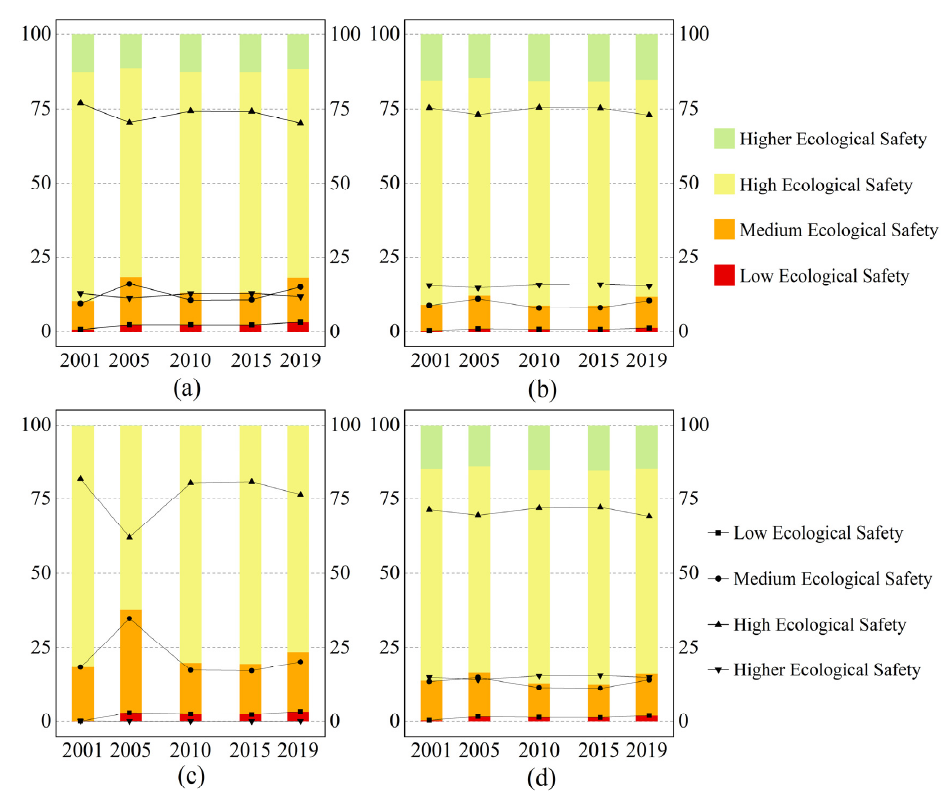
Figure 5. Proportions of areas with different ES levels in four provinces: ( a ) Jiangsu, ( b ) Anhui, ( c ) Shandong, and ( d )